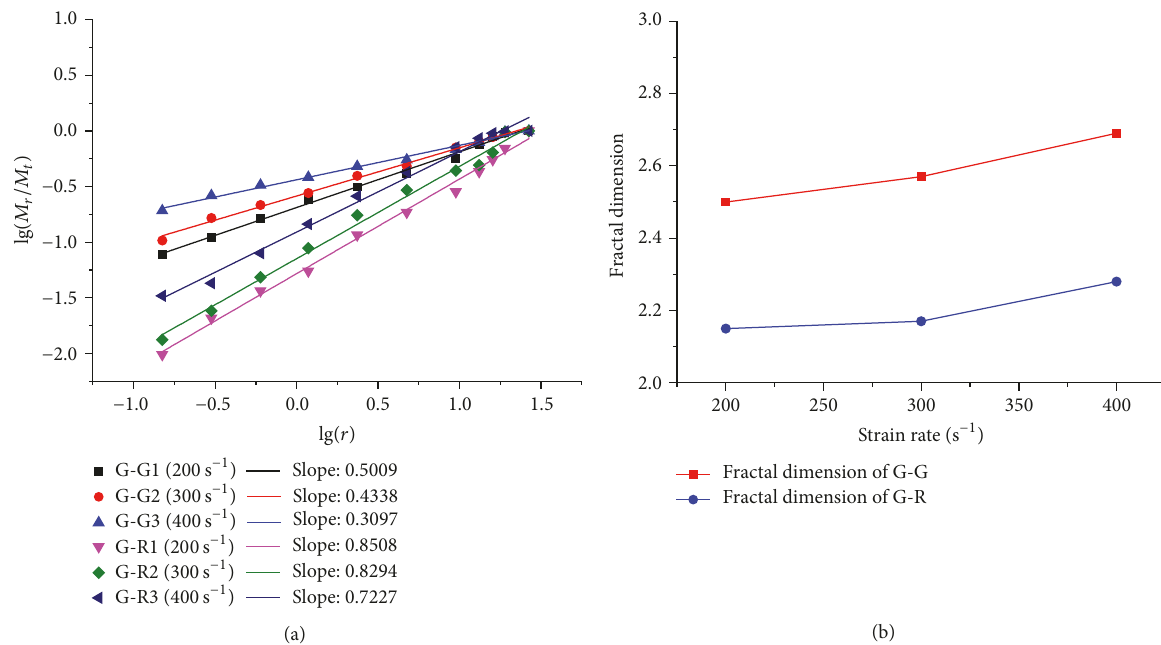
Figure 14: Slope of double logarithmic and fractal dimension of different composite